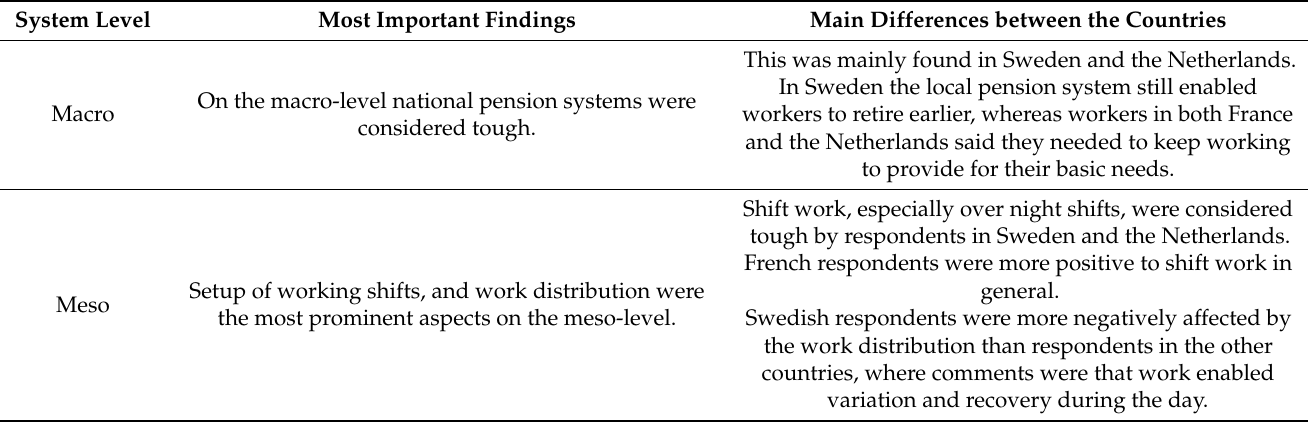
Table 4. Most important findings and main differences between the